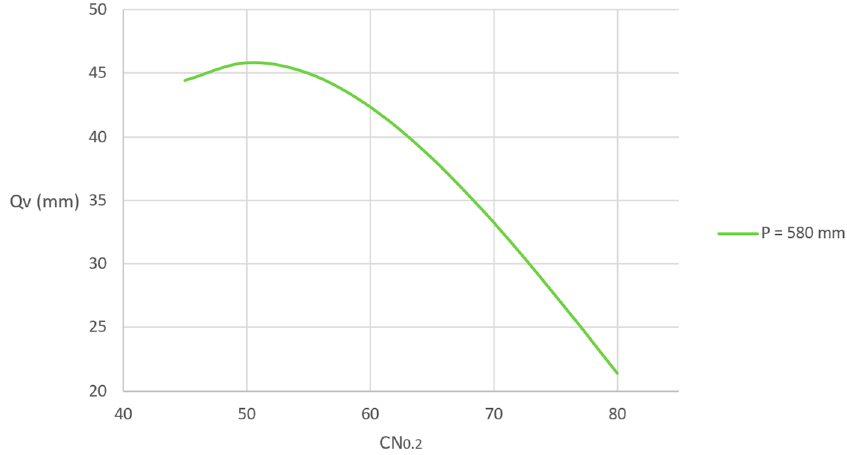
Figure A2: The runoff difference between the conventional SCS-CN rainfall runoff model (Equation Figure A2. The runoff difference between the conventional SCS-CN rainfall runoff model